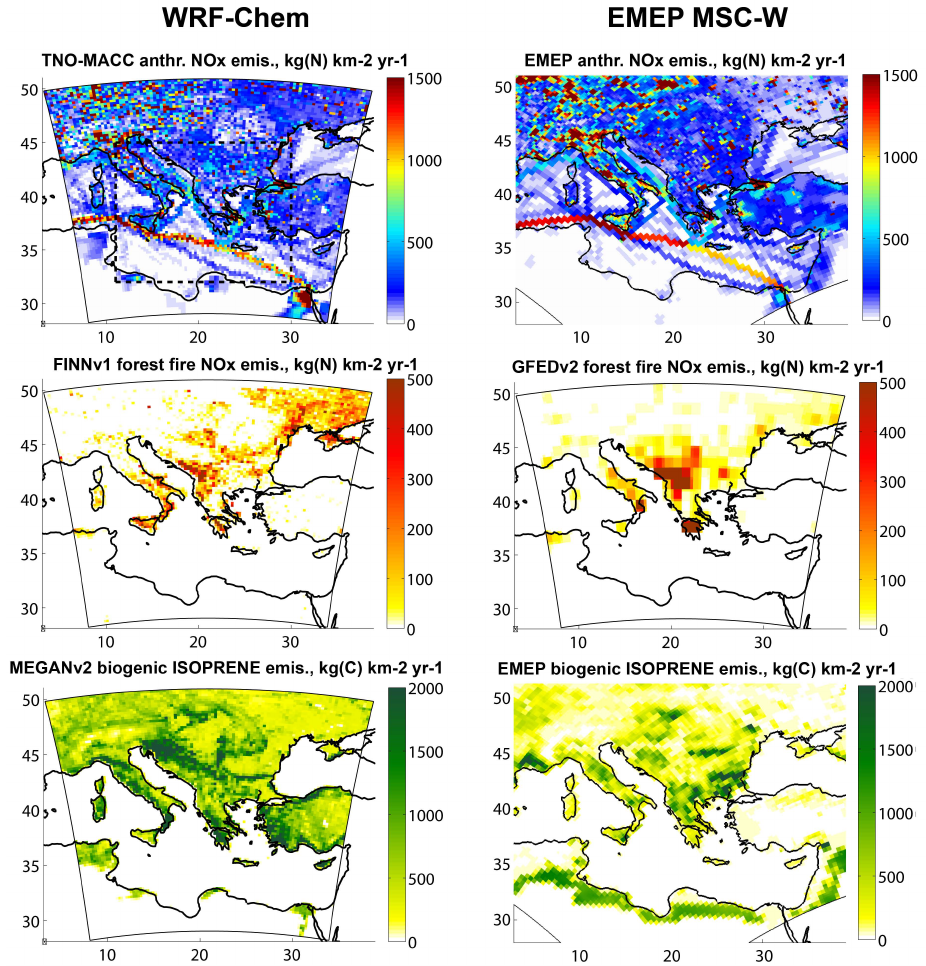
Fig. 2. Seasonally (June, July, August) averaged emissions of NO x (kg(N)km − 2 yr − 1 ) from anthropogenic sources (top) and forest fires (middle), and emissions of isoprene (kg(C) km − 2 yr − 1 ) from biogenic sources (bottom) as used in the reference simulations of the WRF- Chem (left) and EMEP MSC-W (right) models. The dashed rectangle in the topleft plot marks the EM region.